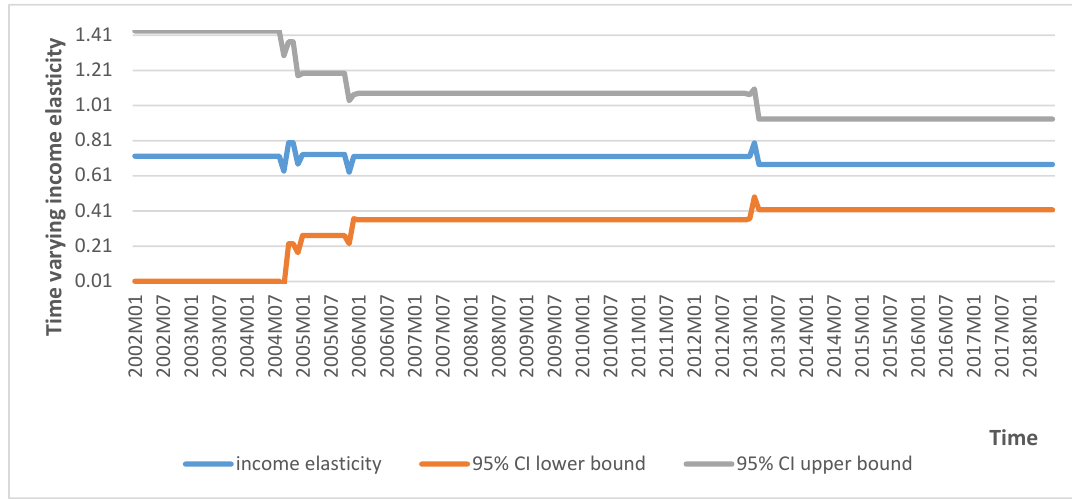
Table 8. MIS long-run estimation results.